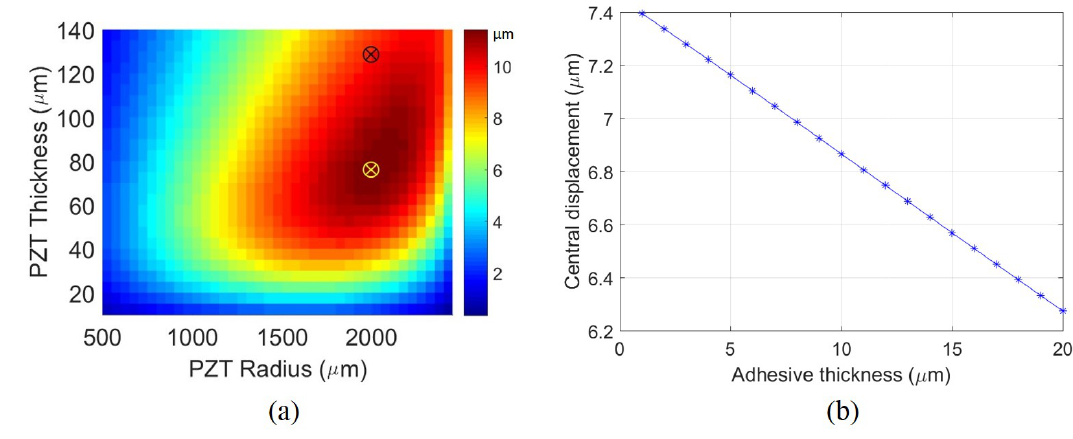
Figure 2. Optimization for maximum actuator displacement: ( a ) Central displacement (shown as color-bar) plotted for different Lead Zirconate Titanate (PZT) parameters using the analytical formulation. The yellow cross is the optimal set of parameters and the black cross is the set of fabricated parameters. Steel diameter = 5mm, Steel thickness = 50µm. ( b ) Dependence of microactuator displacement on adhesive thickness using COMSOL Multiphysics v5.3: PZT radius = 2mm, PZT thickness = 127µm [12], Voltage =